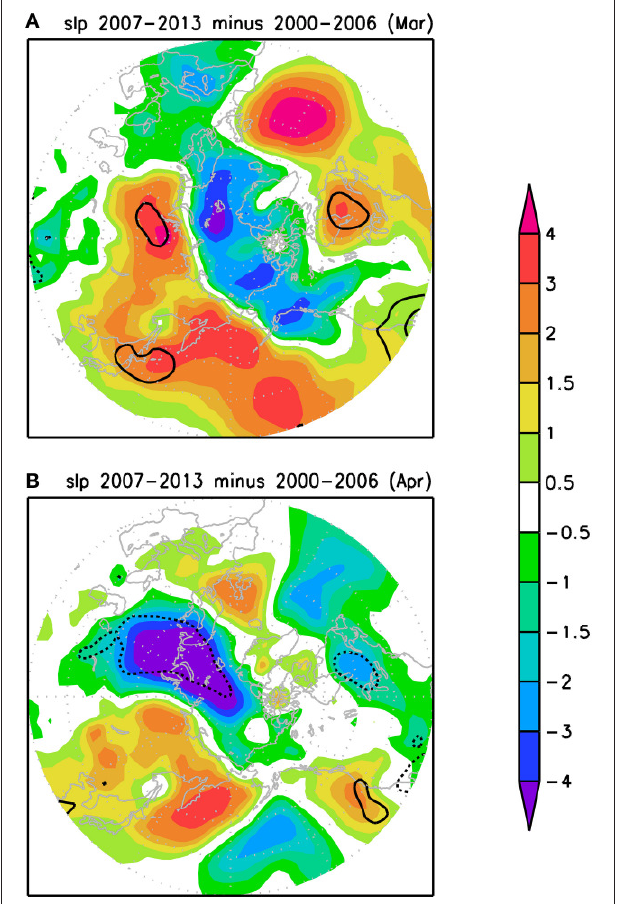
FIGURE 6 | Difference of sea level pressure (hPa) in March (A) and April (B) derived as mean during 2007–2013minus that during 2000–2006. The thick lines denote that the difference between 2007–2013 and 2000–2006 is significant at the 95% confidence level according to the Student t -test.